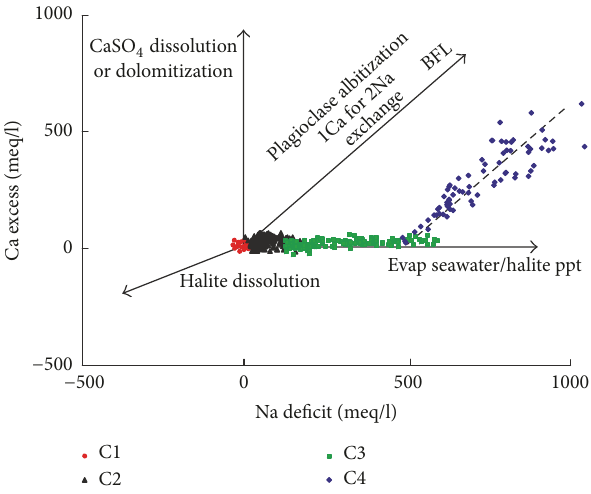
Figure 10: The diagram of Ca excess-Na deficit from different types of formation water in buried hill of Jizhong